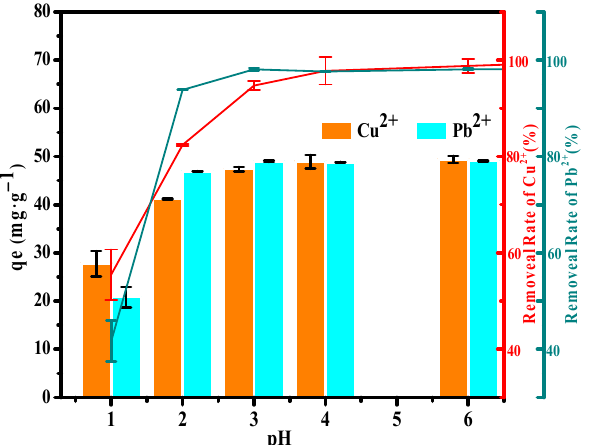
Figure 8. Effect of pH and recycle adsorption performance of TA for Cu(II) and Pb(II). Cation initial concentration was 200 mg·L −1 , adsorbent dosage was 0.1 g, 25°C.